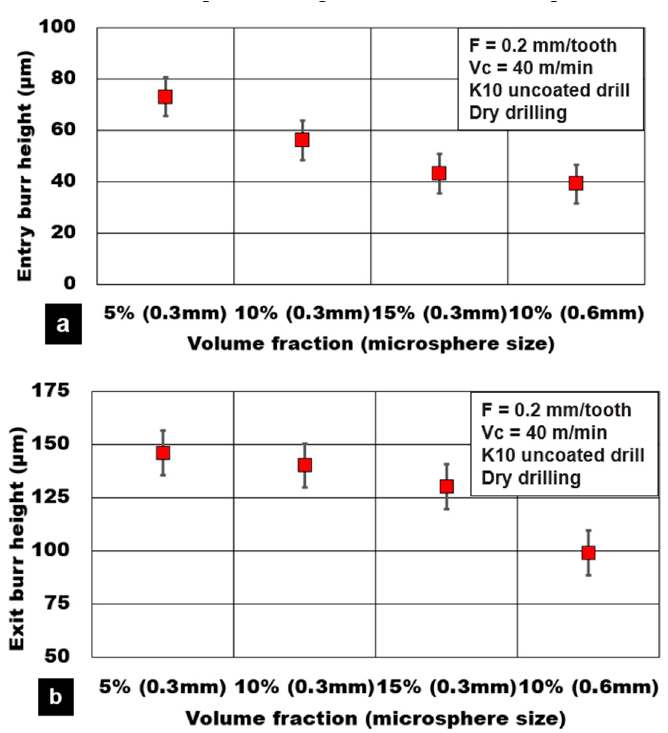
Figure 11. Effect of hollow microsphere volume fraction and average size on hole burr height during plunge drilling of AZ31-alumina syntactic foam. ( a ) Entry burr height; ( b ) Exit burr height.